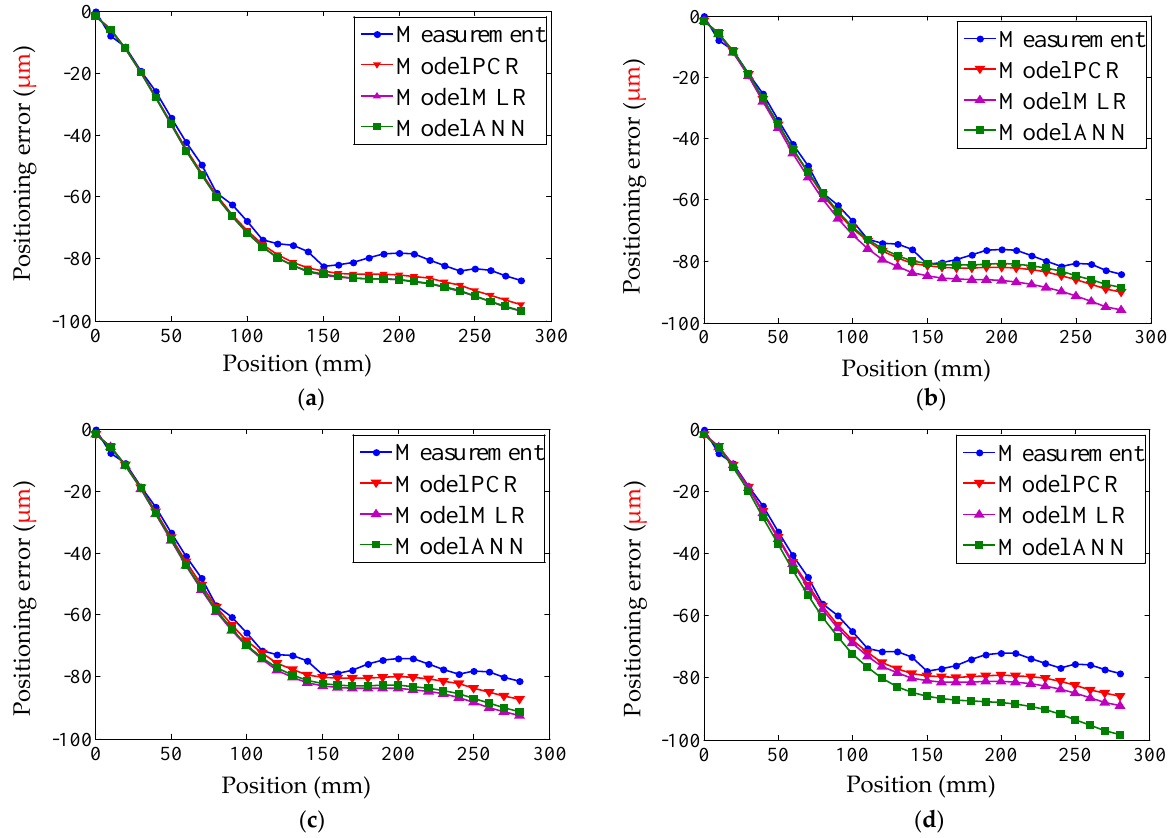
Figure 21. Prediction result of each curve: ( a ) result of the error modeling at 40 min; ( b ) result of the error modeling at 120 min; ( c ) result of the error modeling at 160 min; and ( d ) result of the error modeling at 220 min. Table 21. Prediction results of three models.